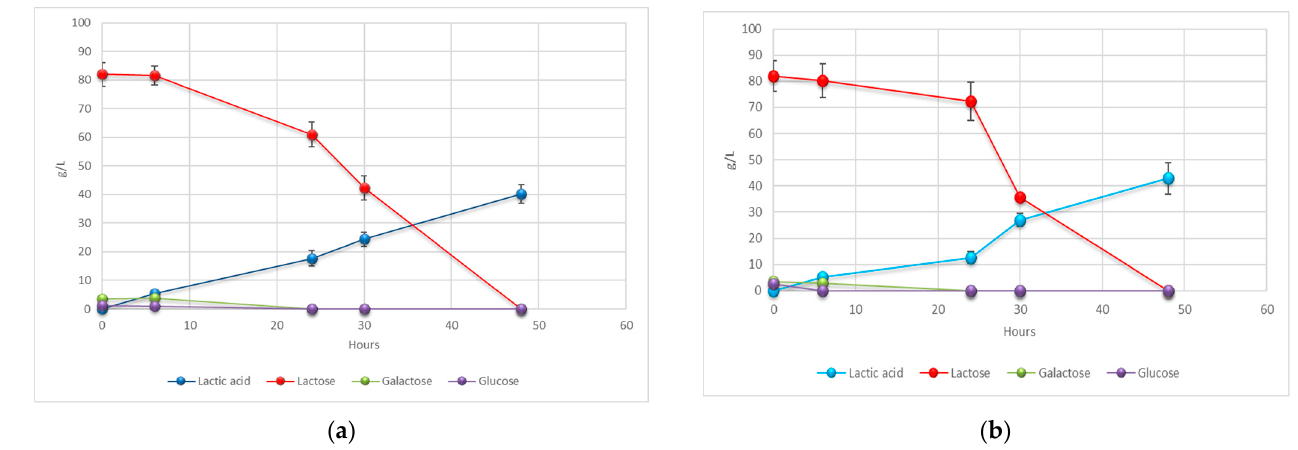
Figure 1. Trend in the concentration of sugars and LA in fermentations with RCW: ( a ) 30 °C; ( b ) 37 °C.